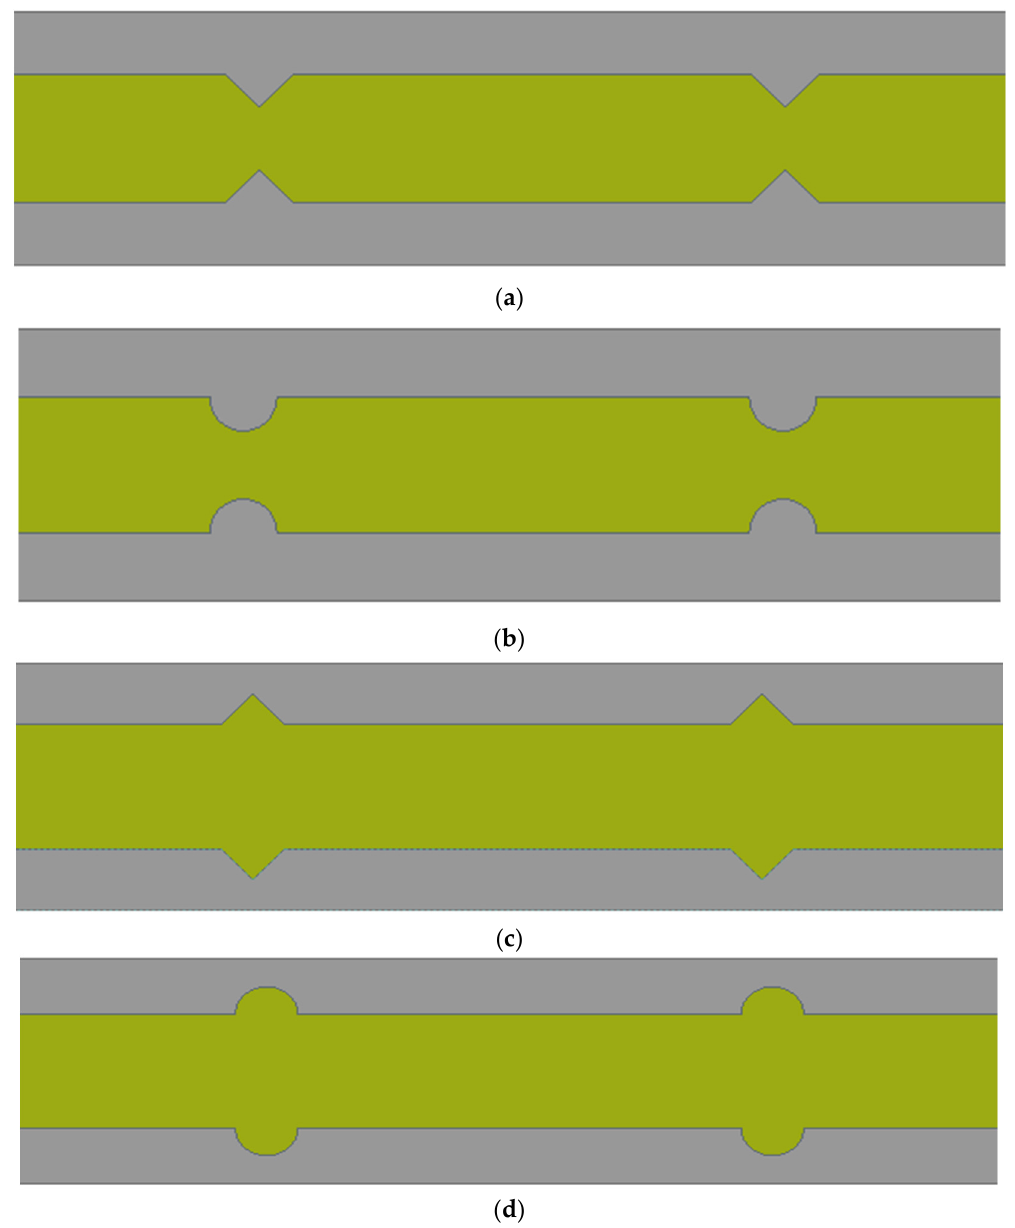
Figure 2. Top view of microchannel heat sink: ( a ) Type 1: extended triangular surface, ( b ) Type 2: extended circular surface, ( c ) Type 3: triangular groove surface, ( d ) Type 4: circular groove surface.